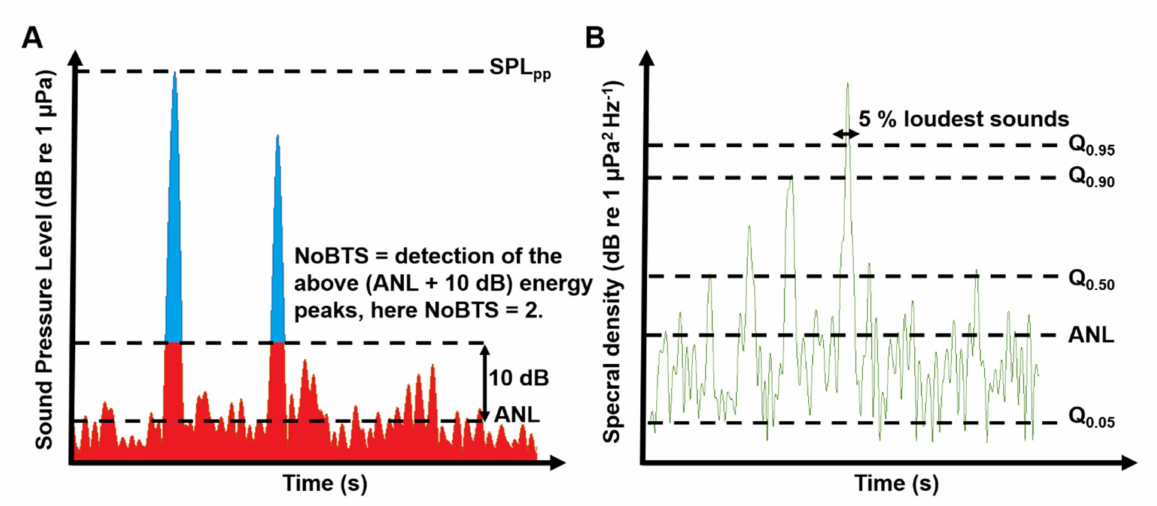
Figure 2. Description of the acoustic features for ( A) benthic invertebrates sounds (for each BTS band) and ( B) fish sounds (200–500 Hz). In blue: nearby sources producing loud and short individual energy peaks; in red, a collection of a large number of distant unidentified sources producing a background chorus. SPL = Sound Pressure Level, pp = peak to peak, NoBTS = number of Broadband Transient Sounds, ANL = ambient noise level, Q = percentile, with Q 0.05 = 5% faintest sounds, Q 0.50 = median levels, Q 0.90 = 10% loudest sounds and Q 0.95 = 5% loudest